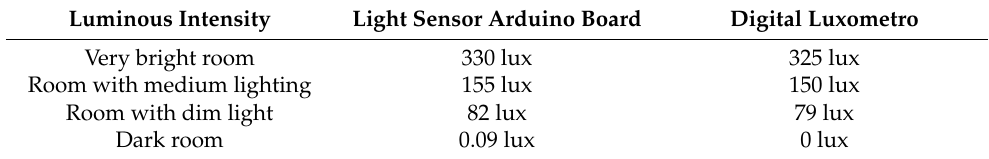
Table 5. Luminosity Sensor.